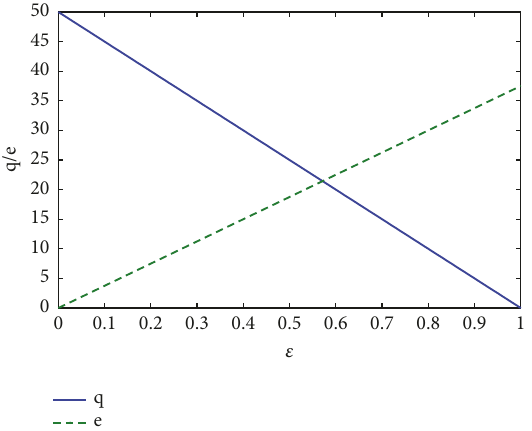
Figure 4: The changes of product quality (platform advertisement).